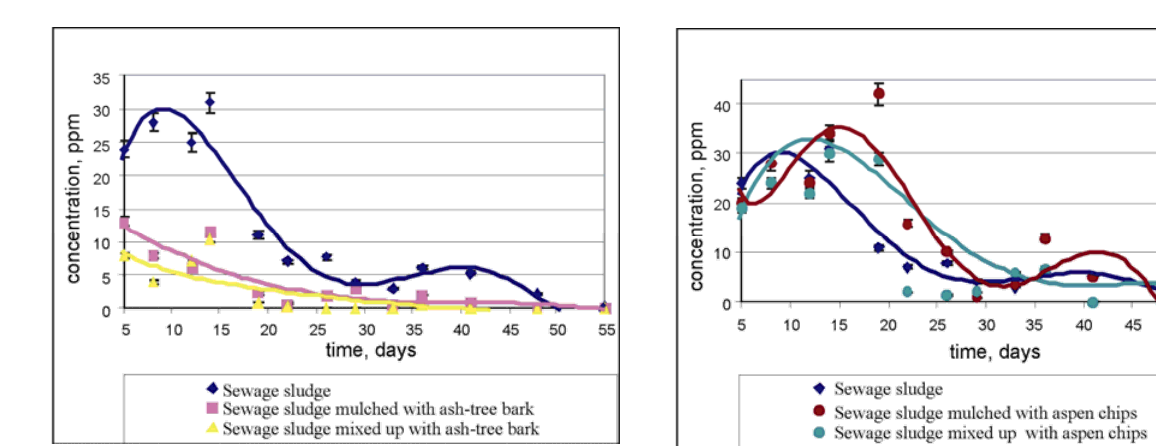
Fig. 13. Hydrogen sulphide emissions during composting sew- age sludge with oak sawdust